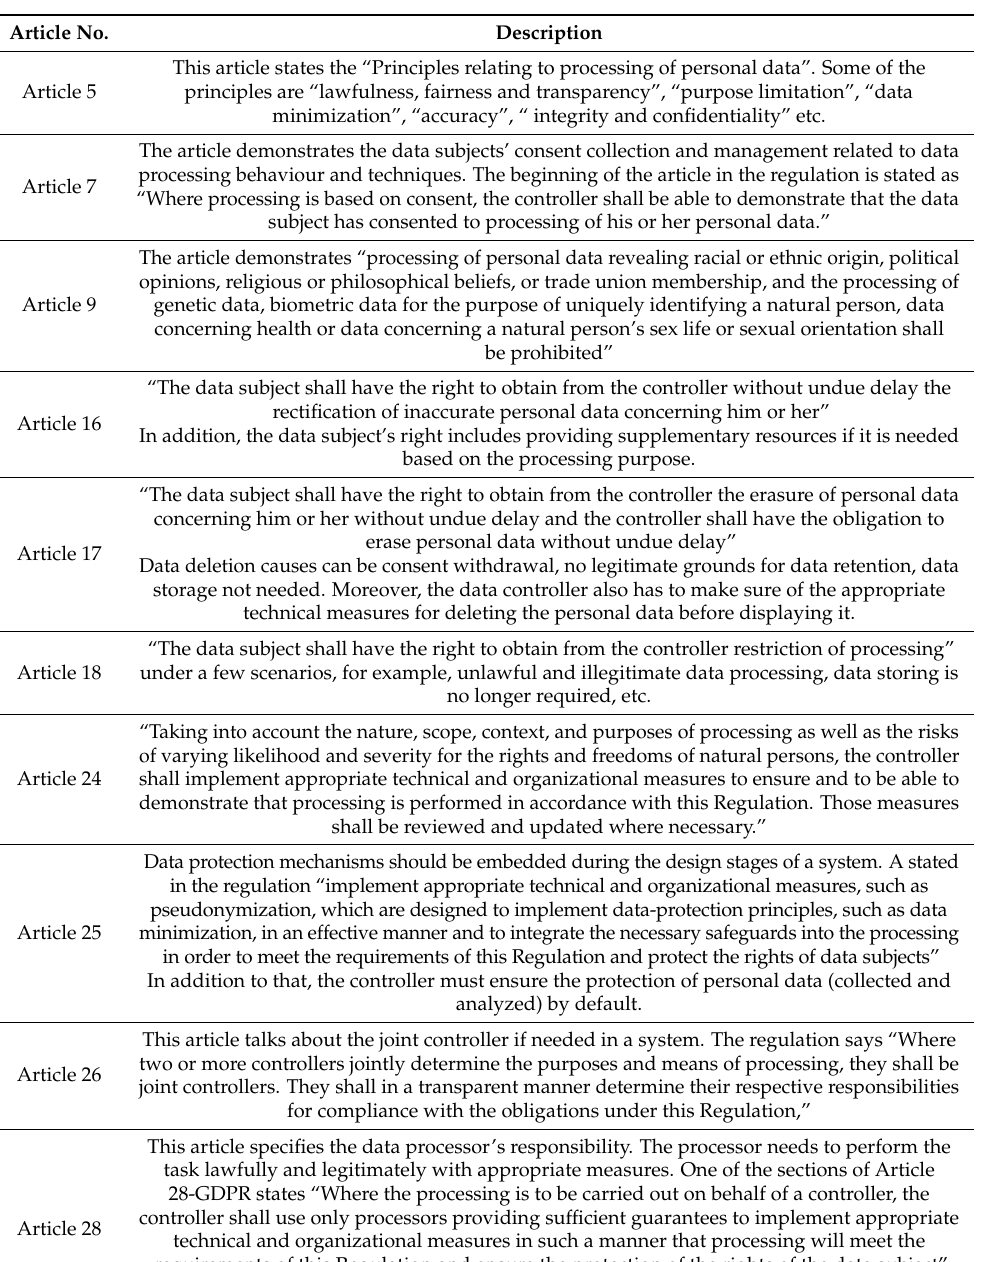
Table 1. Relevant General Data Protection Regulations (GDPR) articles for blockchain-based